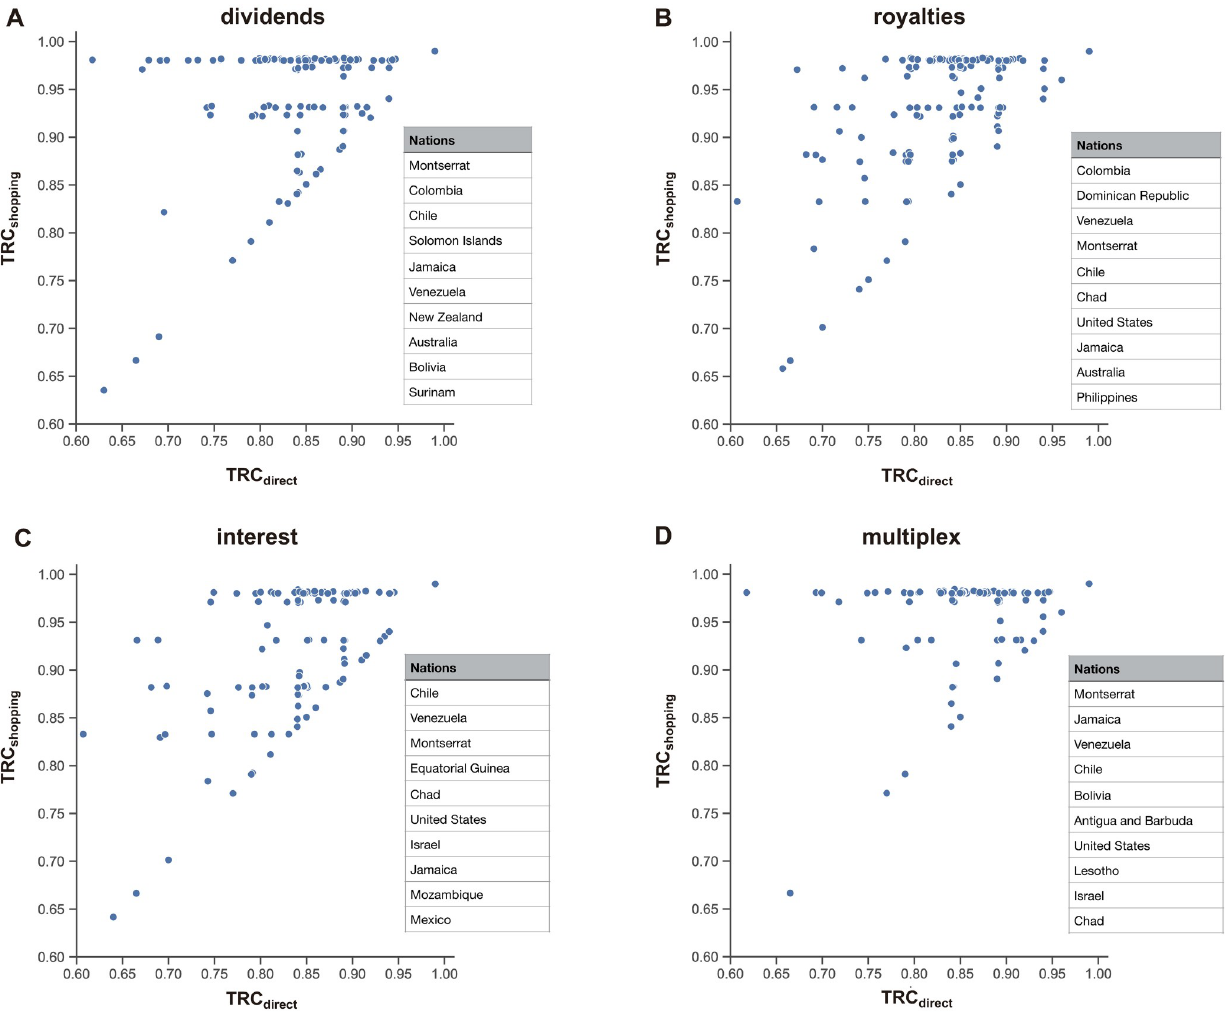
Fig 3. Pairwise comparison between direct and shopping routes for (A) dividends, (B) royalties, (C) interest, and (D) the multiplex